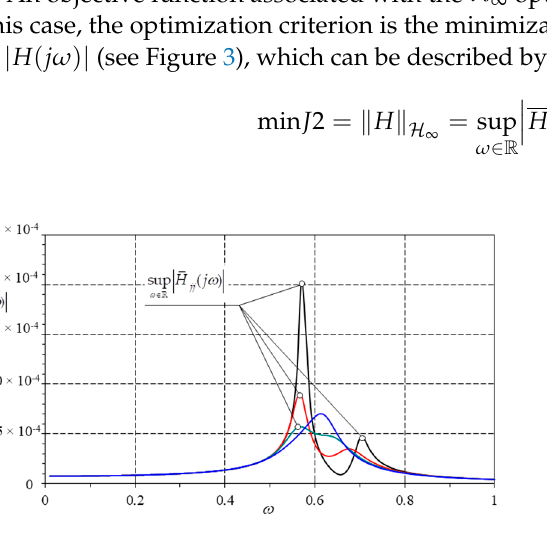
Figure 3. Objective function J 2 determination diagram (maximum value).